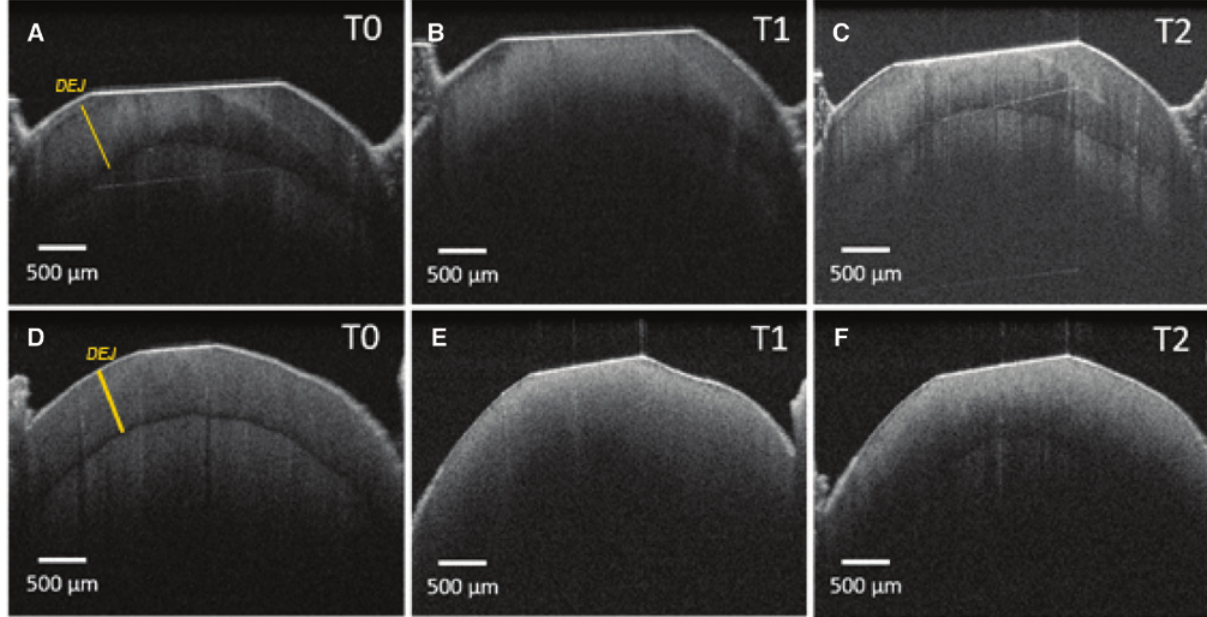
Figure 6: OCT images acquired from representative samples of the NSF group (A, B and C) and negative control (D, E and F) at T0, T1 and T2 phases.